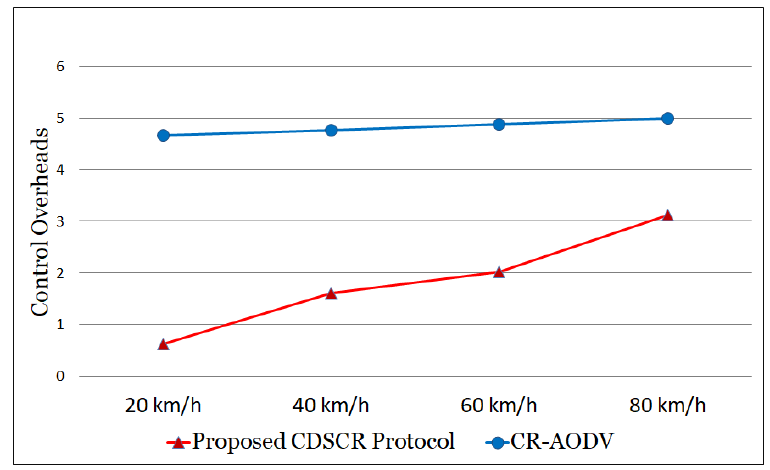
Figure 11. Control overheads versus node mobility.